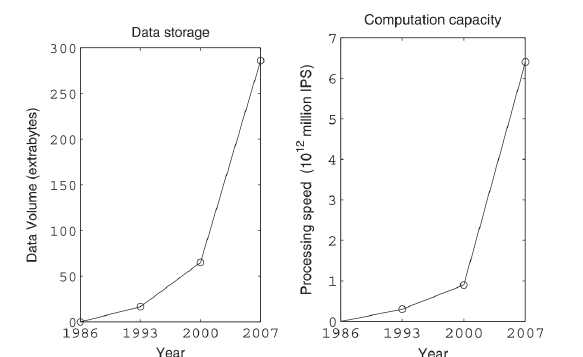
Figure 2: The increase of data size has surpassed the capabilities of computation (C.L. F. Chen and C. Y. Zhang 2014 according to M. Hilbert and P. L´opez,